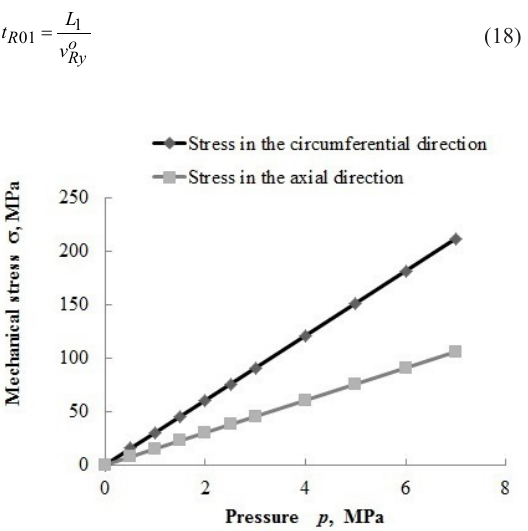
Figure 3. The variations of the circumferential and axial stresses in the water vessel.